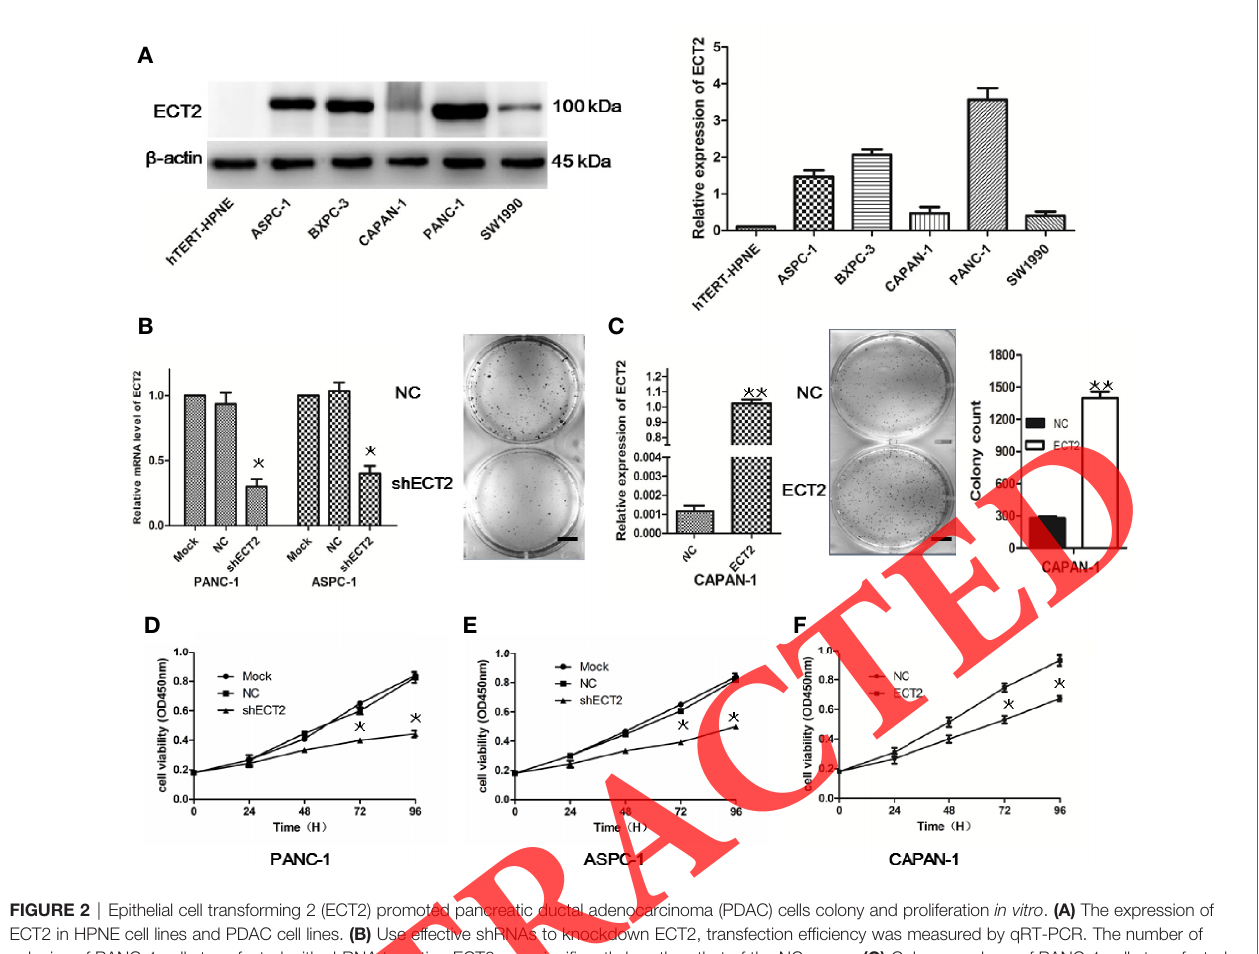
FIGURE 2 | Epithelial cell transforming 2 (ECT2) promoted pancreatic ductal adenocarcinoma (PDAC) cells colony and proliferation in vitro . (A) The expression of ECT2 in HPNE cell lines and PDAC cell lines. (B) Use effective shRNAs to knockdown ECT2, transfection ef fi ciency was measured by qRT-PCR. The number of colonies of PANC-1 cells transfected with shRNA targeting ECT2 was signi fi cantly less than that of the NC group. (C) Colony numbers of PANC-1 cells transfected with ECT2-Flag were signi fi cantly more than numbers of NC groups. (D, E) CCK-8 assay showed knockdown of ECT2 inhibited both AsPC-1 and PANC-1 cells proliferation. (F) CCK-8 assay showed ECT2 overexpress promoted CAPAN-1 cells proliferation. * p <0.05, ** p